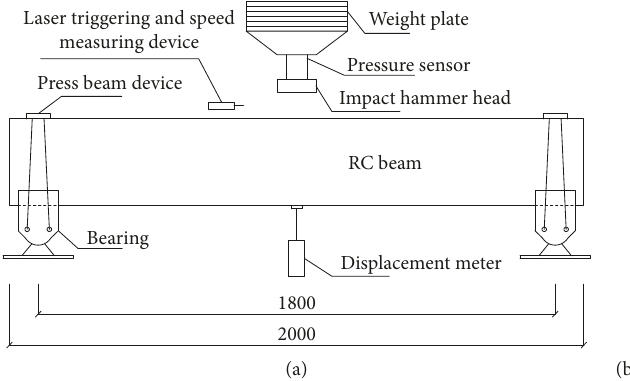
Figure 2: Drop hammer impact test device (mm).